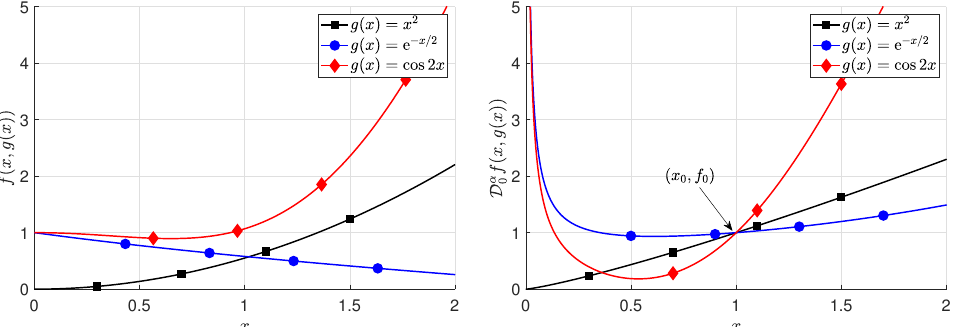
f ( x , g ( x )) ( right plot) for some 0